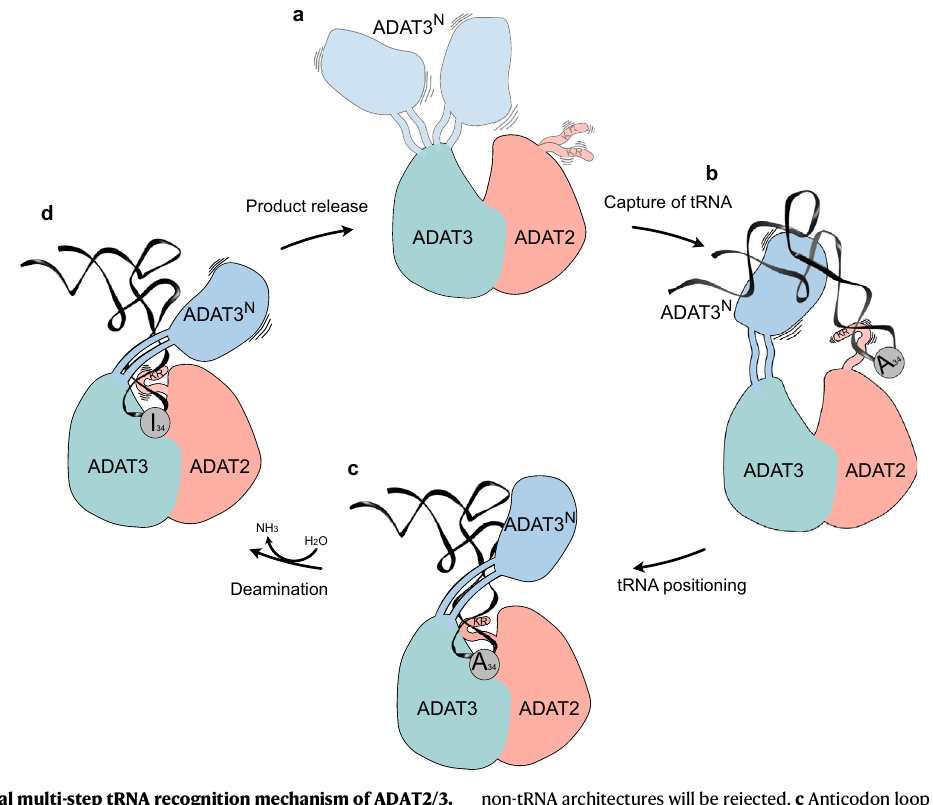
Fig. 6 | The hypothetical multi-step tRNA recognition mechanism ofADAT2/3. a Ligand-freeenzymestate:inthefreeADAT2/3heterodimerADAT2 C isdisordered and ADAT3 N is fl exibly linked. b Initial capture: the RNA recognition motifs in ADAT3 N and in ADAT2 C capture RNA; tRNAs are progressively guided by the extension of favorable interactions towards the anticodon binding cleft;